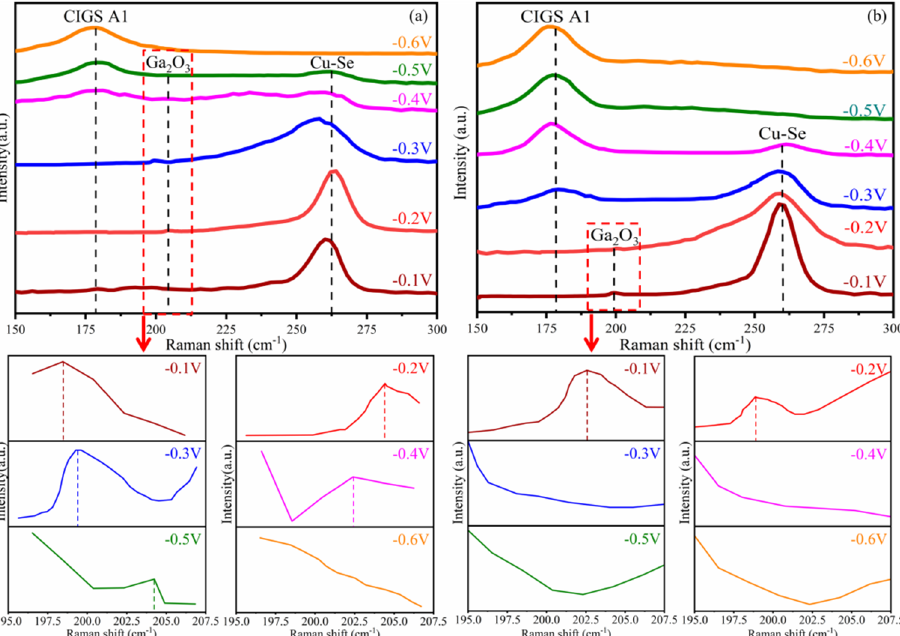
Figure 10. Raman spectra of CIGS thin film prepared at potentials of − 0.1 V to − 0.6 V and pressures of: ( a ) 80 kPa and ( b ) 3 kPa.